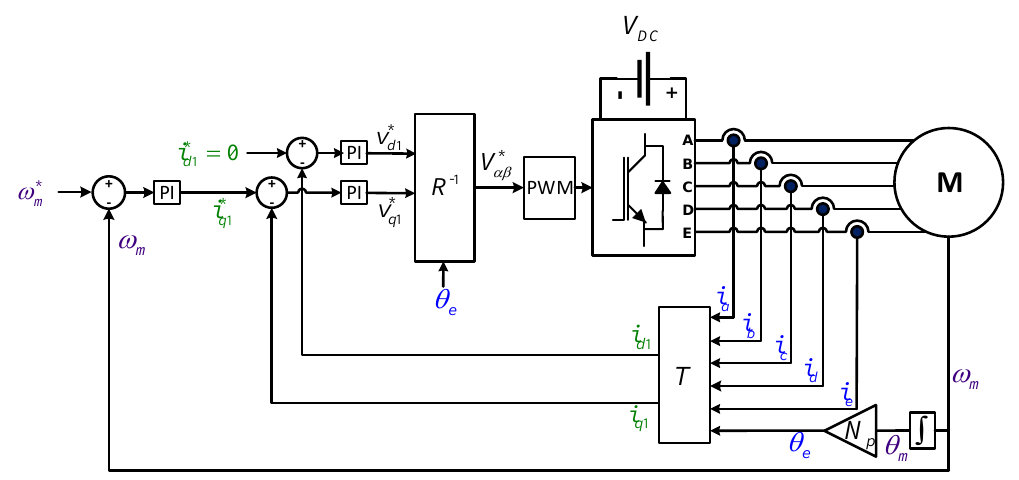
Figure 12. Block diagram of the EMA speed and torque